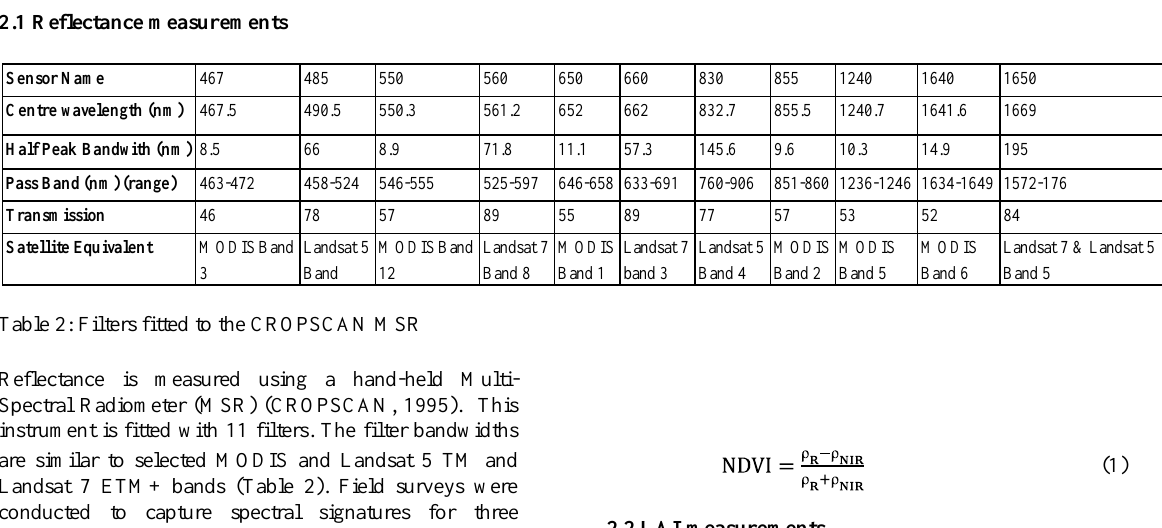
Centre wavelength (nm) 467.5 Half Peak Bandwith (nm)